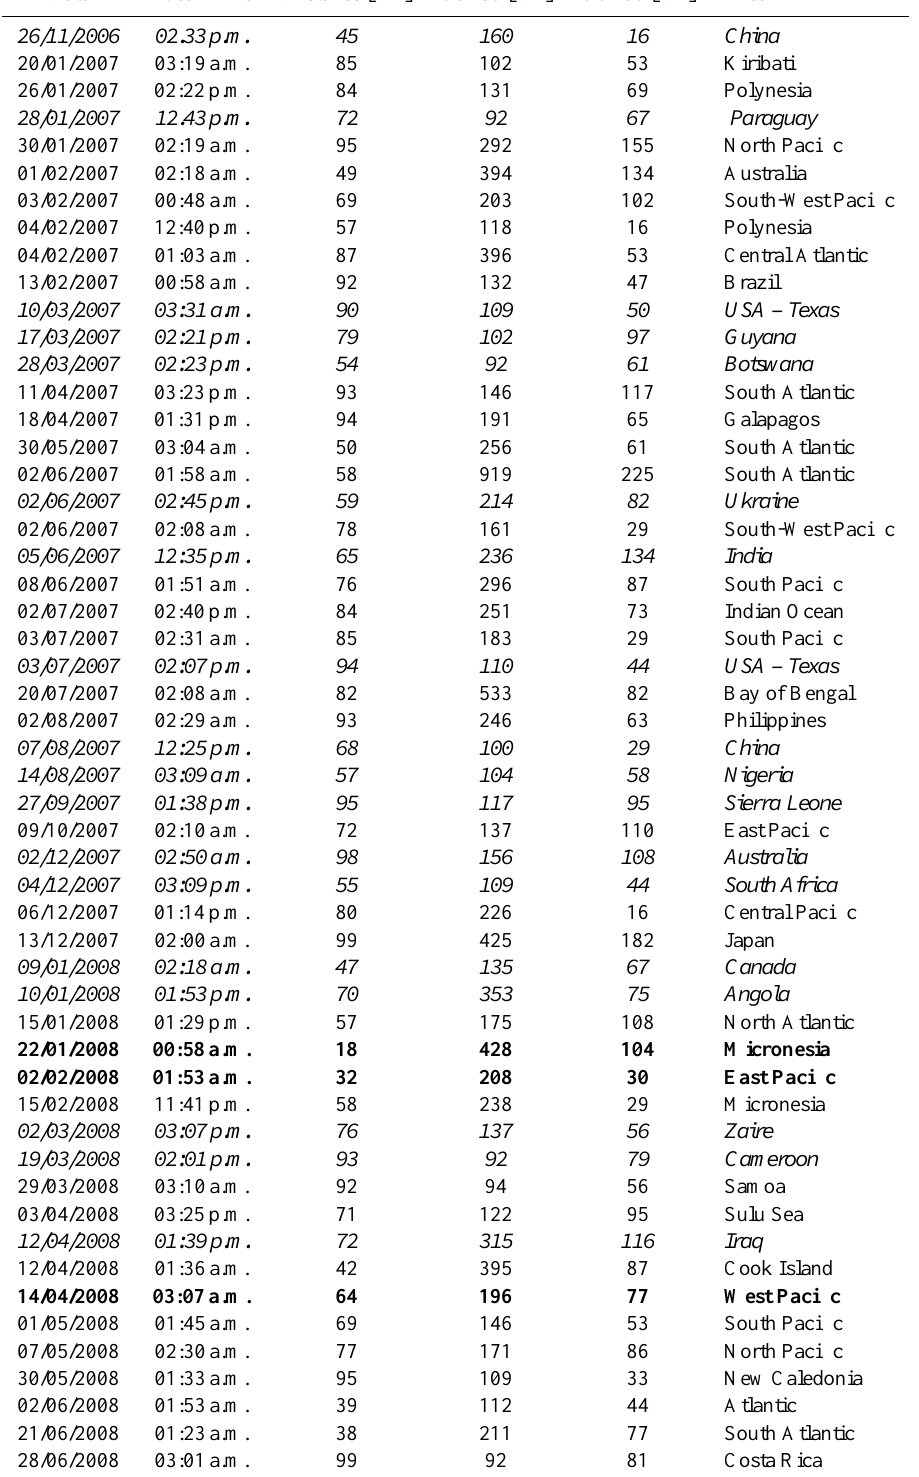
Table 1. Convective Clusters co-located with GPS radio occultation and CALIPSO track. The local time is related to the RO acquisitions. The space distance is related to GPS radio occultation tangent point at 15km of altitude and the closest CALIPSO track coordinates. In bold the cases detailed in the paragraph 4 and in italic the cases on